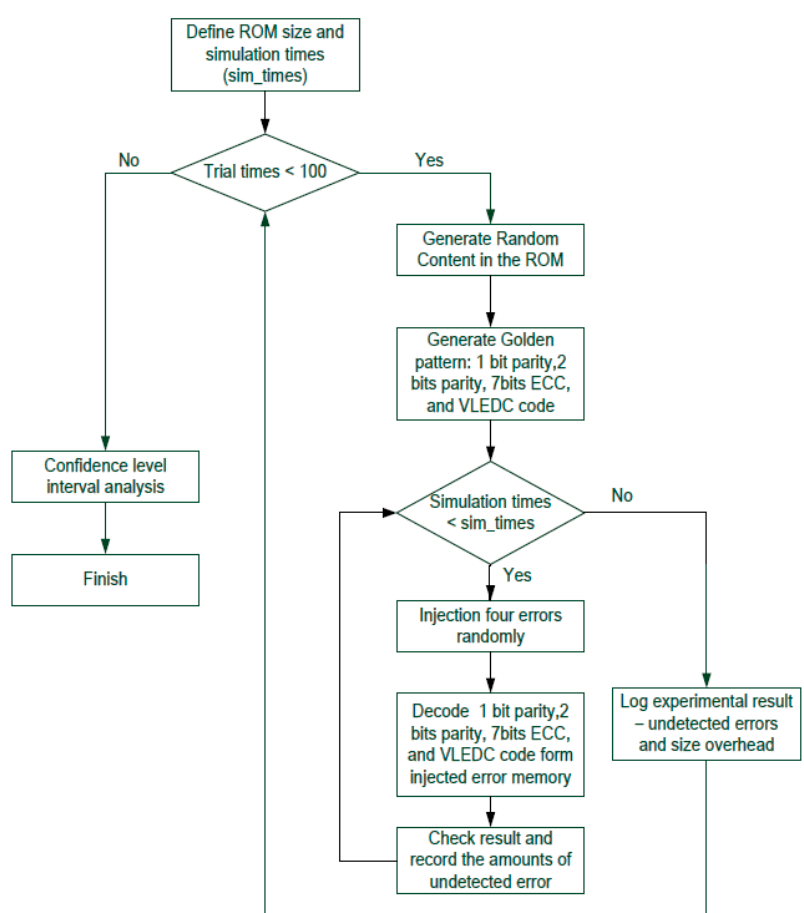
Figure 7. The flow of experiment.